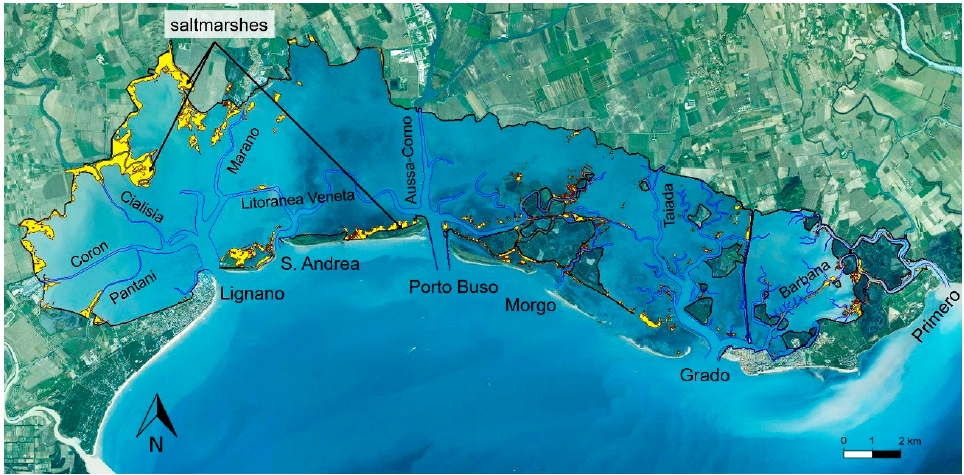
Figure 1. Marano and Grado Lagoon, Italy. The six tidal inlets, the main channels and saltmarshes are highlighted.